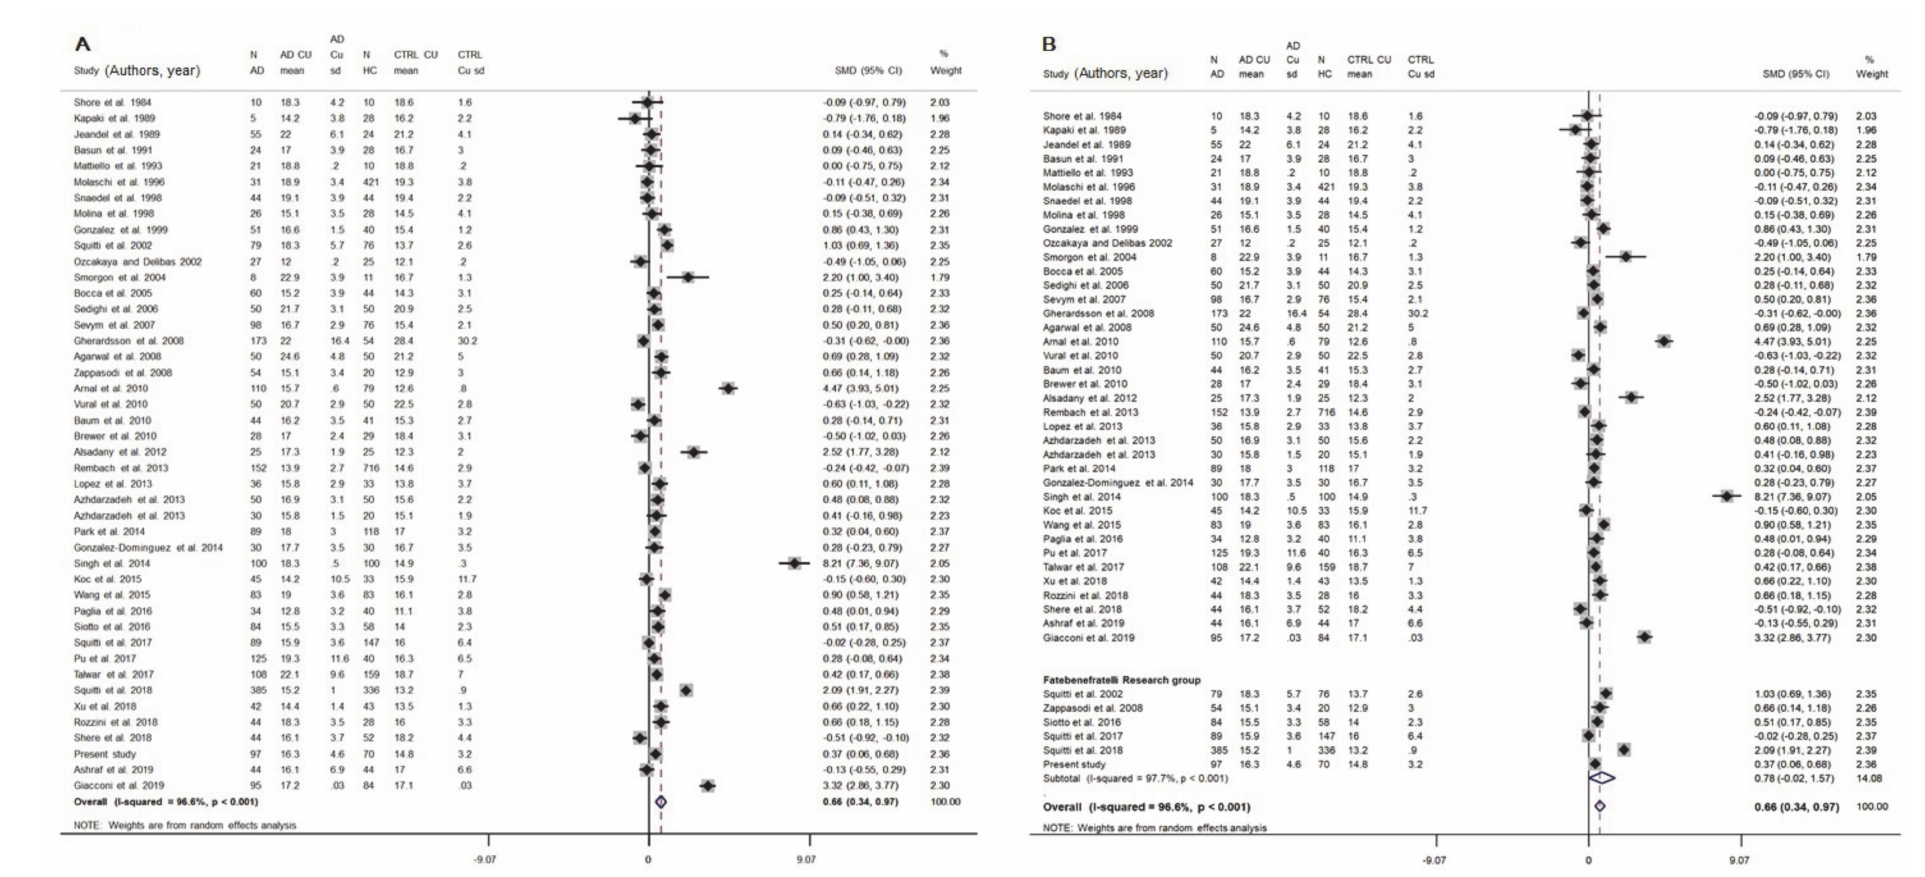
Figure 3. Standardized mean difference (SMD) computed from the studies on Cu serum/plasma levels ( µ mol/L) in AD patients and HC subjects. SMDs between patients and controls are represented by squares, whose sizes are proportional to the sample size of the relative study. The whiskers represent the 95% confidence interval (CI). The diamond represents the pooled estimate based on the random-effects model, with the center representing the point estimate and the width indicating the associated 95% CI. In panel ( A ) is the study-wise analysis; in panel ( B ) is the group-wise analysis. Abbreviations: PY, publication year; N, number; SD, standard deviation; HC, healthy